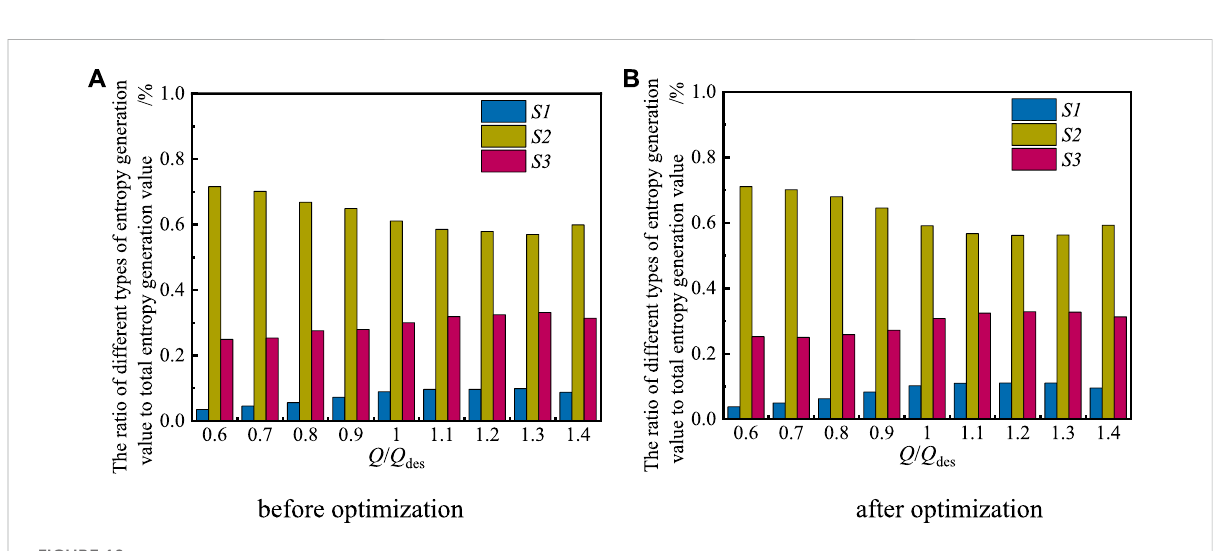
FIGURE 10 Ratio of different types of entropy generation to total entropy generation before and after optimization. (A) before optimization (B) after